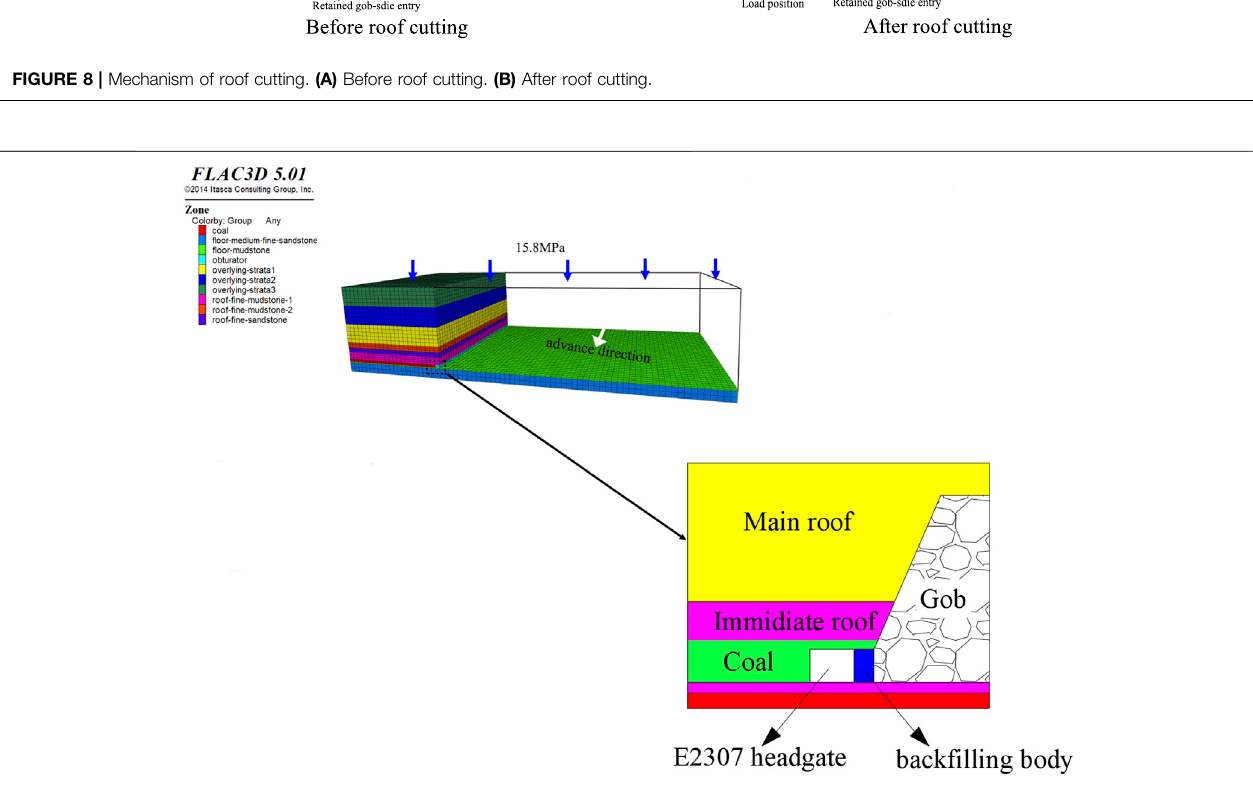
FIGURE 9 | Simulation